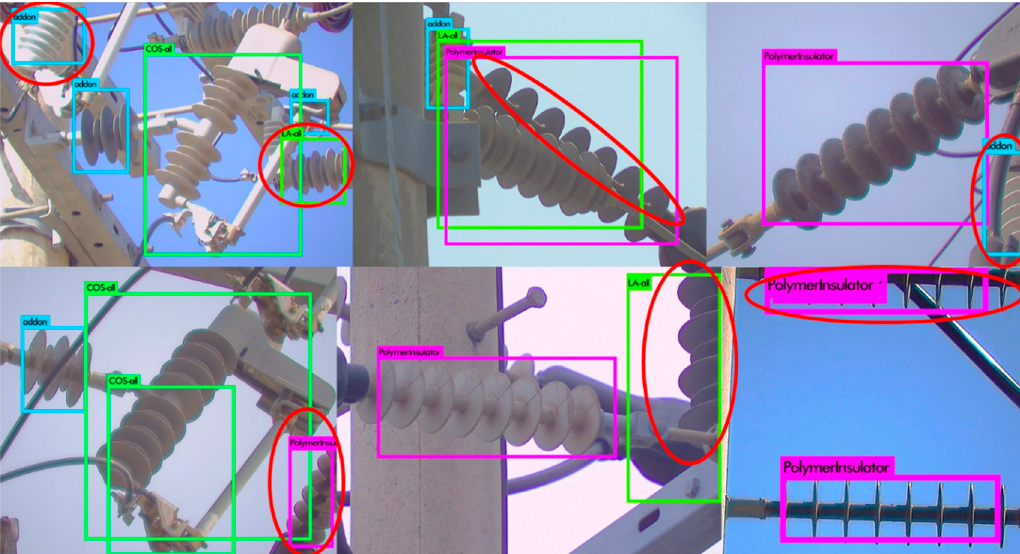
Figure 11. Robustness of CNN-based electrical equipment detector leads to the detection of occluded equipment, which is treated as false positive by our testing routine. Examples of these false positive detections are marked with red circles in this figure.